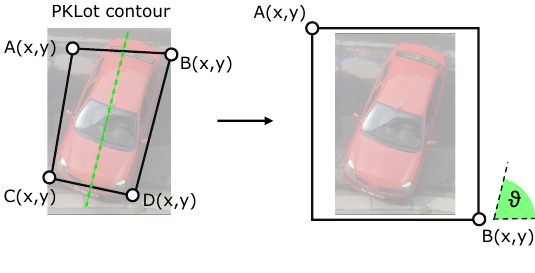
Figure 7. Transformation of